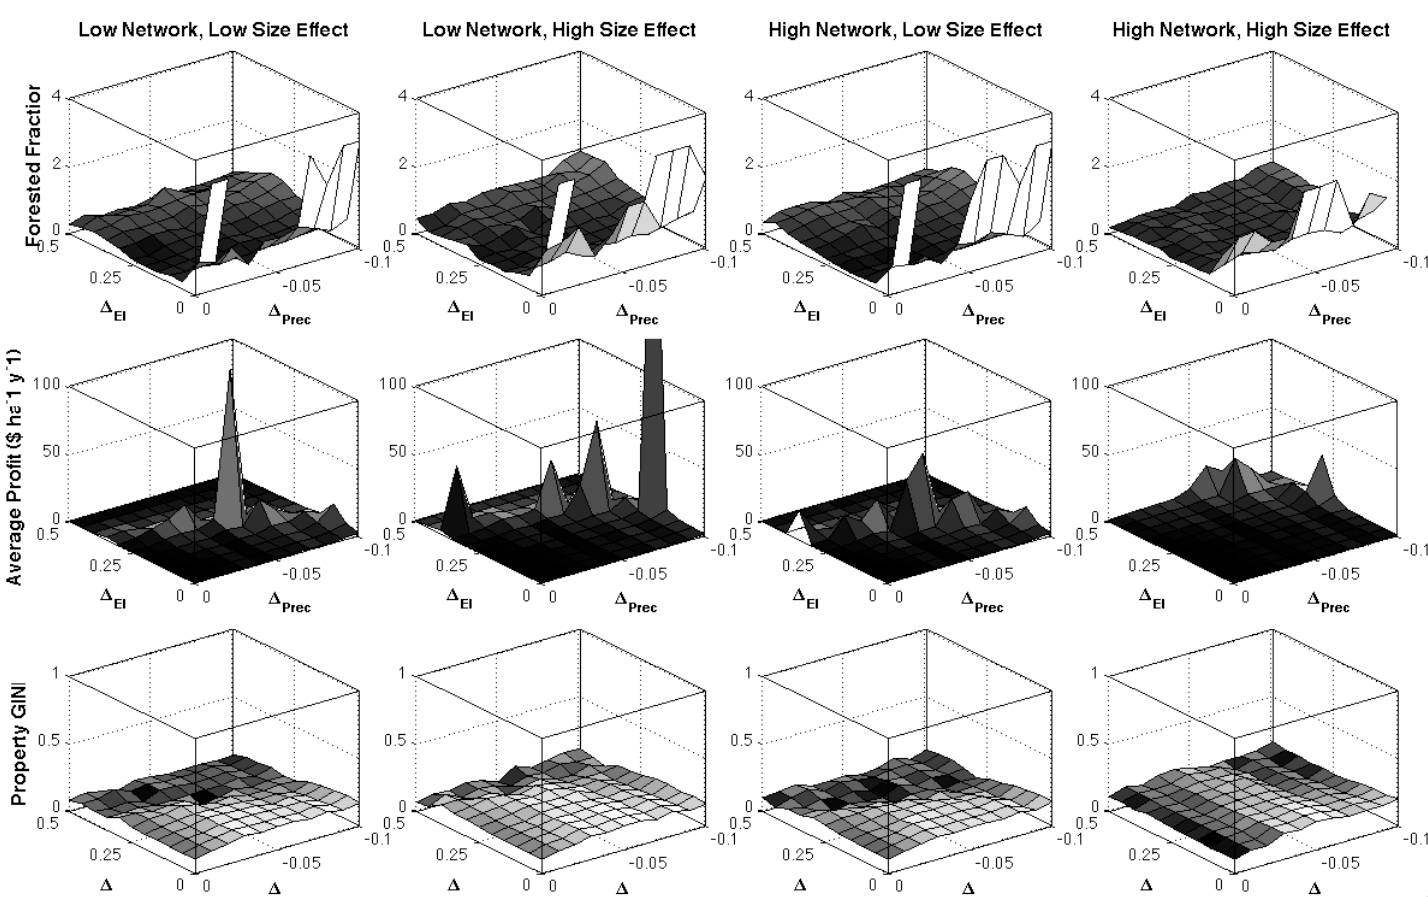
Figure A5.6: Relative standard deviations for response surfaces for Policy Scenario 2 – Sensitivity to change in expected income Δ EI and in precipitation Δ Prec , tiered environmental licensing. Surfaces in row 1 show standard deviation for forested fraction across the landscape; row 2 shows standard deviation for profit per hectare of property per year; row 3 shows the standard deviation for level of land aggregation measured by the property GINI coefficient. Each column represents a different scenario of rancher interaction. Values reflect the standard deviation across n replicates, divided by the mean across the n